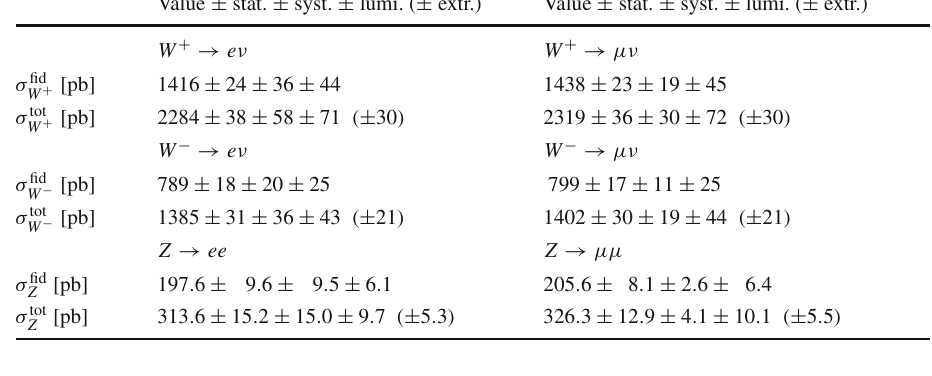
total cross-section measurements for W + -boson, W − -boson and Z